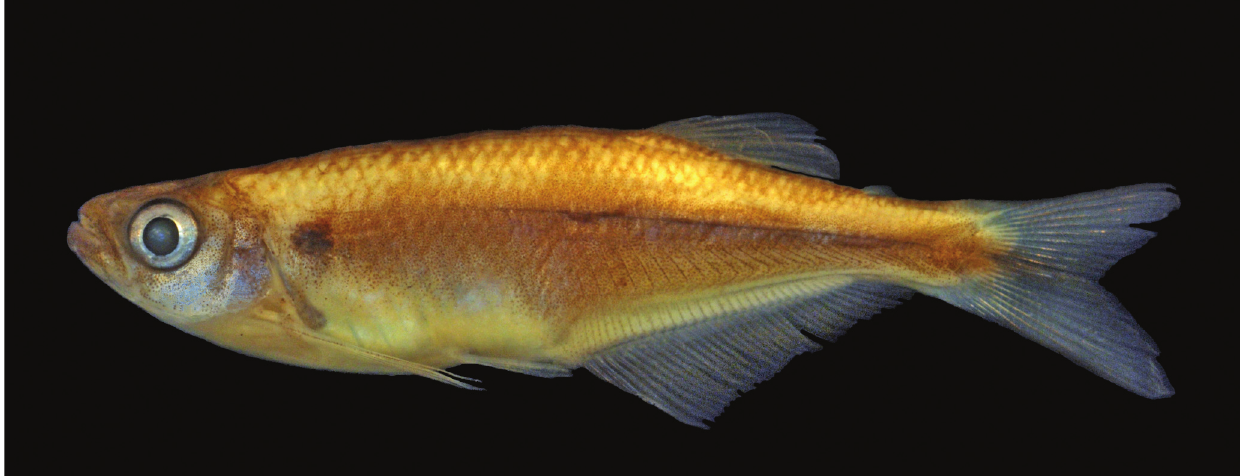
Fig. 2. Chrysobrycon eliasi , female, paratype, MUSM 39973, 37.63 mm SL, Peru, Madre de Dios, río Madre de Dios basin, Creek Loboyoc.